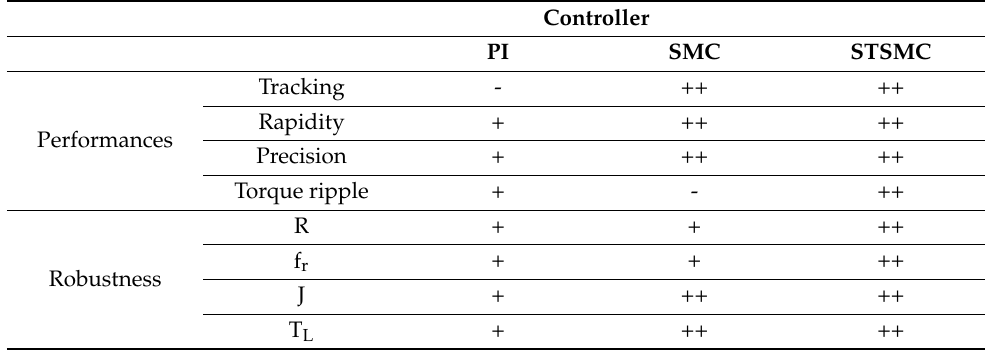
Table 3. Performances and robustness evaluation of the three